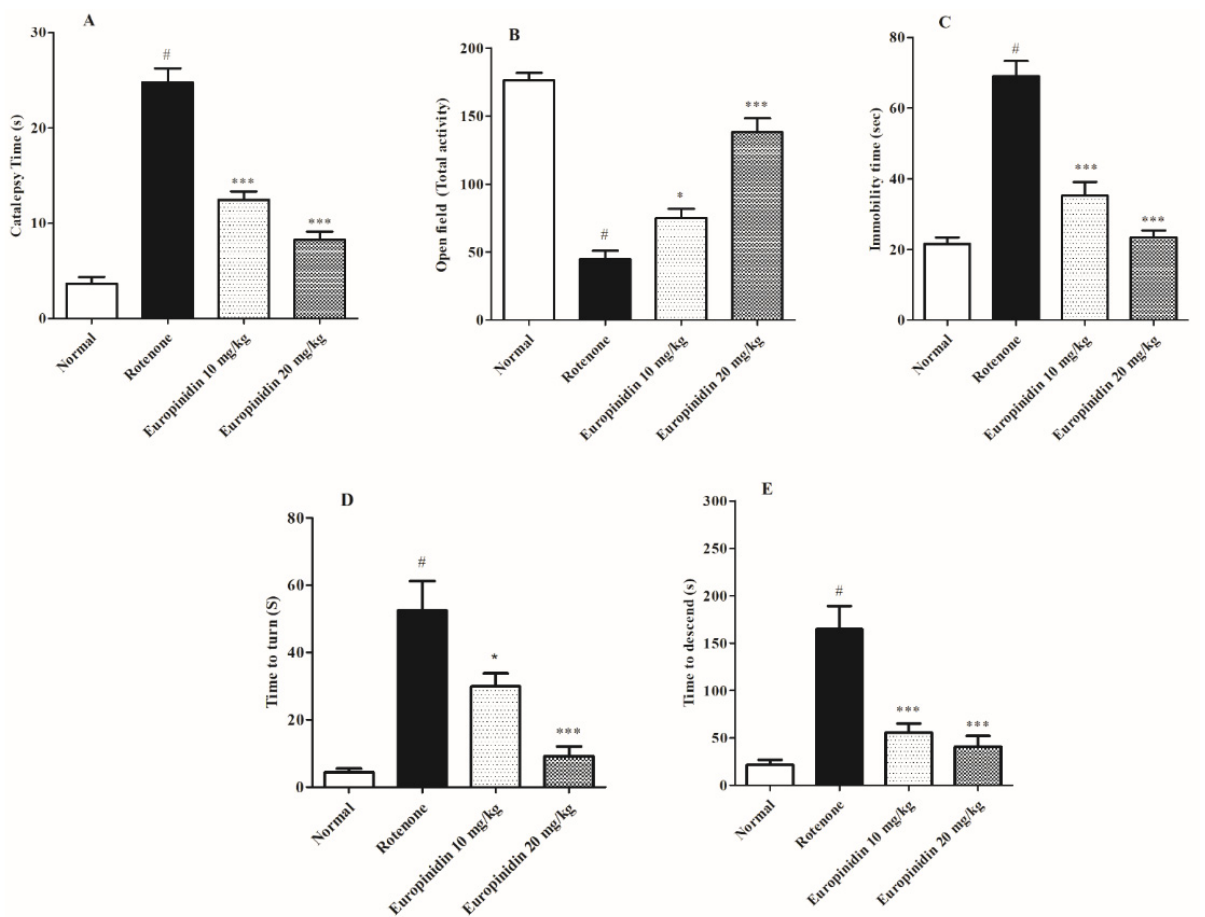
Figure 1. Effect of europinidin on behavioural parameters. ( A ) Catalepsy time, ( B ) Open field activity, ( C ) Immobility time, ( D ) t-turn, ( E ) t-total. The data were expressed as mean ± S.E.M. ( n = 6/group). * p < 0.05, *** p < 0.001 when compared with control group; # p < 0.001 when compared with rotenone group (one-way ANOVA followed by Tukey’s